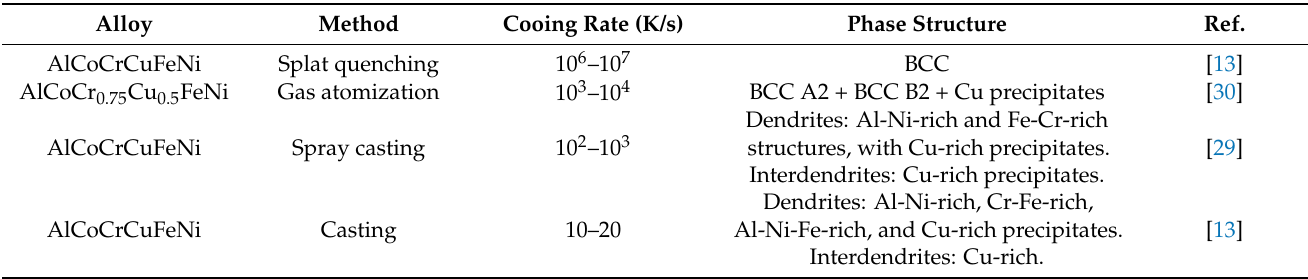
Table 1. Phase formation in correlation to fabrication method and cooling rate in AlCoCrCuFeNi based